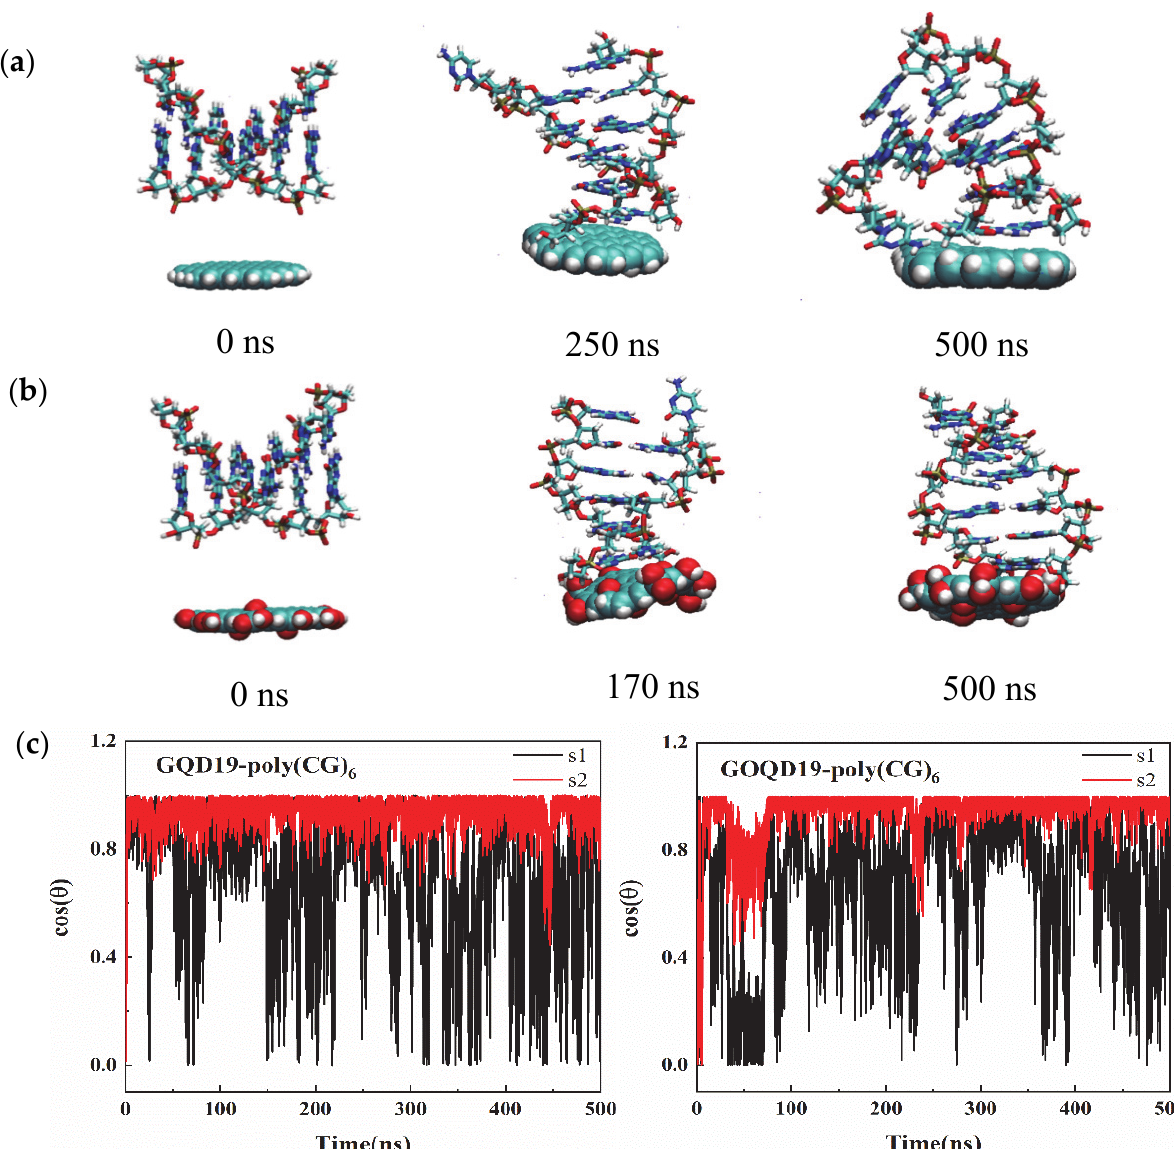
Figure 4. ( a ) Representative snapshots of dsDNA adsorption on ( a ) GQD19 and ( b ) GOQD19 surface. ( c ) The angle between the axis of the two single strands of dsDNA and the normal of the GQD19/GOQD19 surface during the simulation.